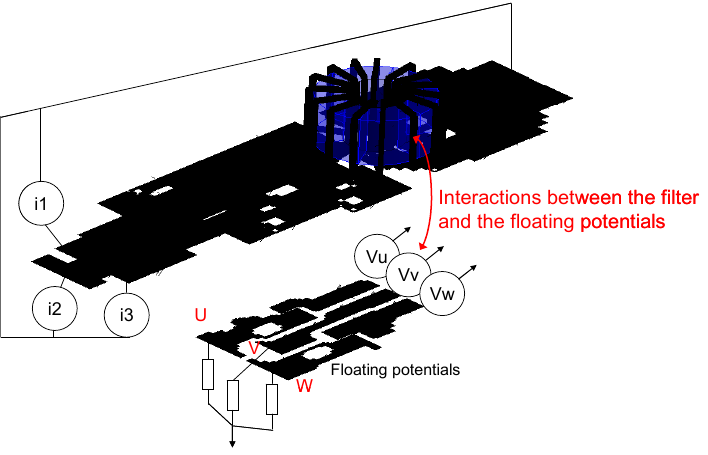
Figure 5. Electrical topology to model